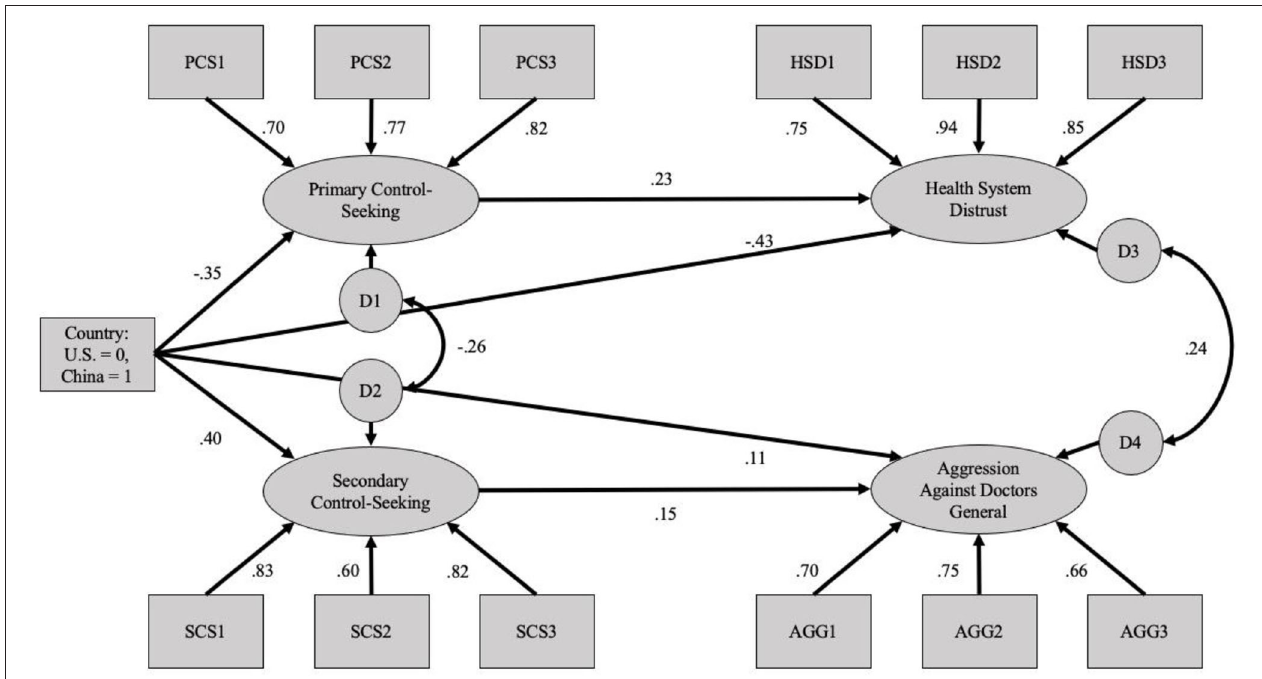
FIGURE 2 | Mediation structural equation model using the general aggression against doctors scenarios (Study 2).